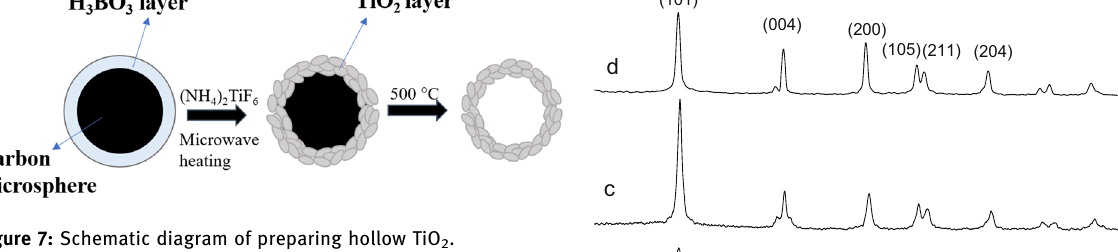
Figure 7: Schematic diagram of preparing hollow TiO 2 .